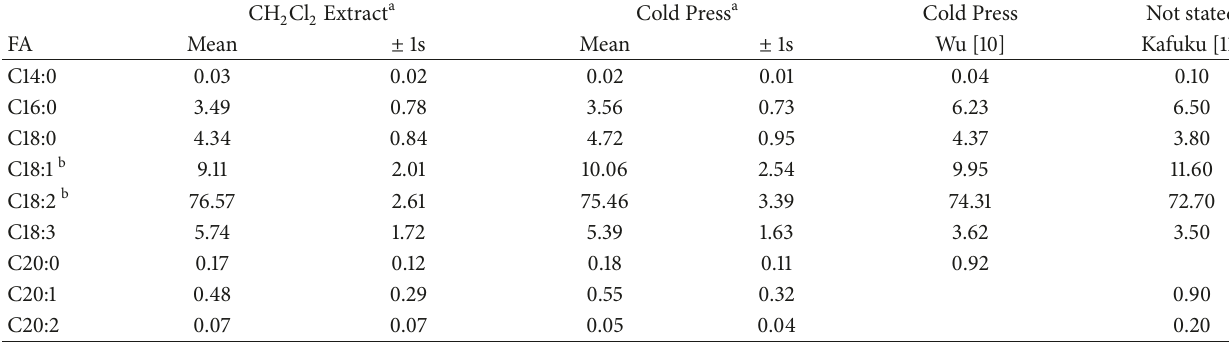
Table 2: GC-MS relative percent fatty acid